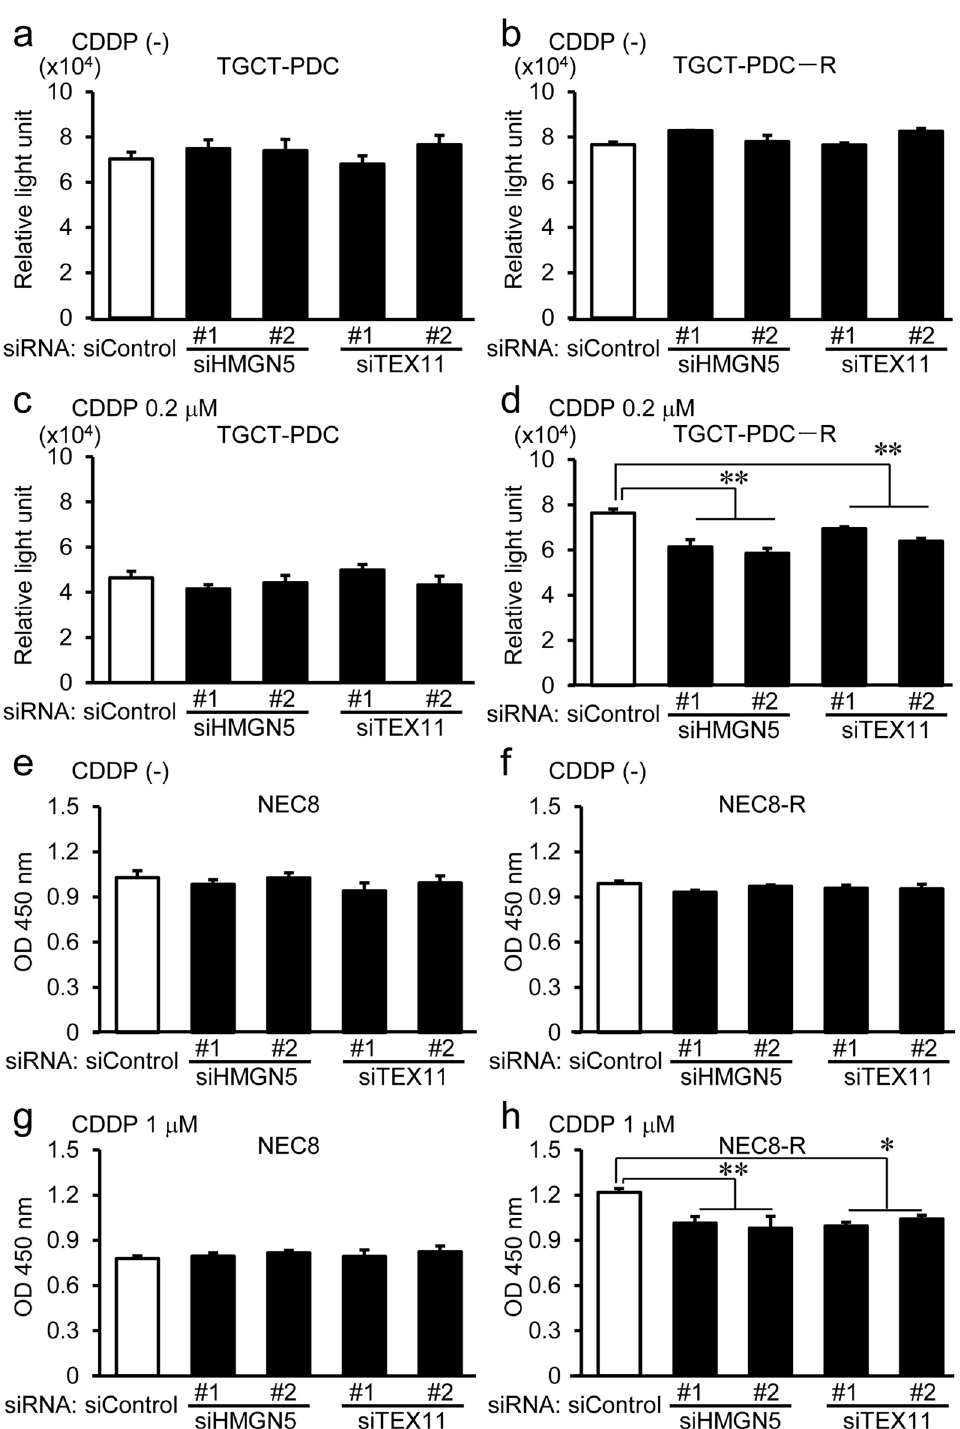
Figure 2. Silencing of HMGN5 and TEX11 attenuates the proliferation of cisplatin-resistant TGCT-PDC and NEC8 cells in the presence of cisplatin. (a, b) Effects of control siRNA (siControl), HMGN5 -specific siRNAs (siHMGN5 #1 and #2), or TEX11 -specific siRNAs (siTEX11 #1 and #2) on the viability of parental TGCT-PDC (a) and cisplatin-resistant TGCT-PDC-R (b) cells analyzed by quantitation of intracellular ATP content in the absence of cisplatin. Results are shown as mean ± SE (n = 4). (c, d) HMGN5 - and TEX11 -specific siRNAs repress the viability of TGCT-PDC-R cells (d) but not of TGCT-PDC cells (c) treated with cisplatin (0.2 μM). (e, f) Effects of indicated siRNAs on the viability of parental NEC8 (e) and cisplatin-resistant NEC8-R (f) cells analyzed by WST-8 cell proliferation assay in the absence of cisplatin. (g, h) HMGN5 - and TEX11 -specific siRNAs repress the viability of NEC8-R cells (g) but not of NEC8 cells (h) treated with cisplatin (0.2 μM). *, P < 0.05; **, P <